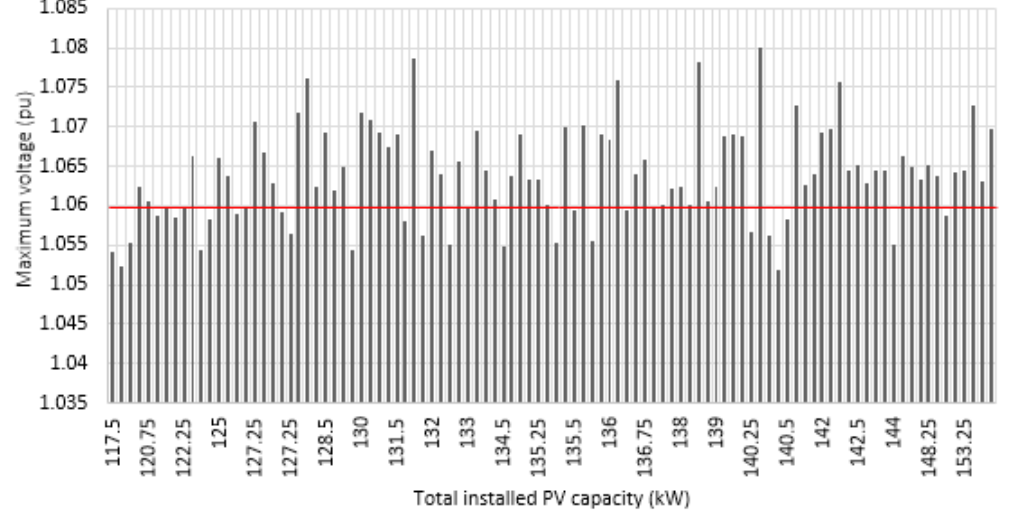
Figure 10: Variation of maximum voltage with the total installed PV capacity (30 PV